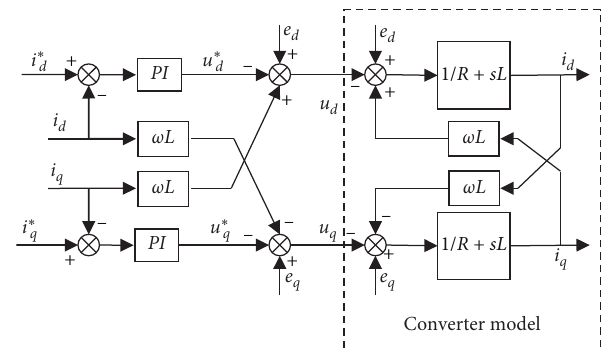
Figure 6: Current loop control diagram of grid voltage feedforward decoupling.